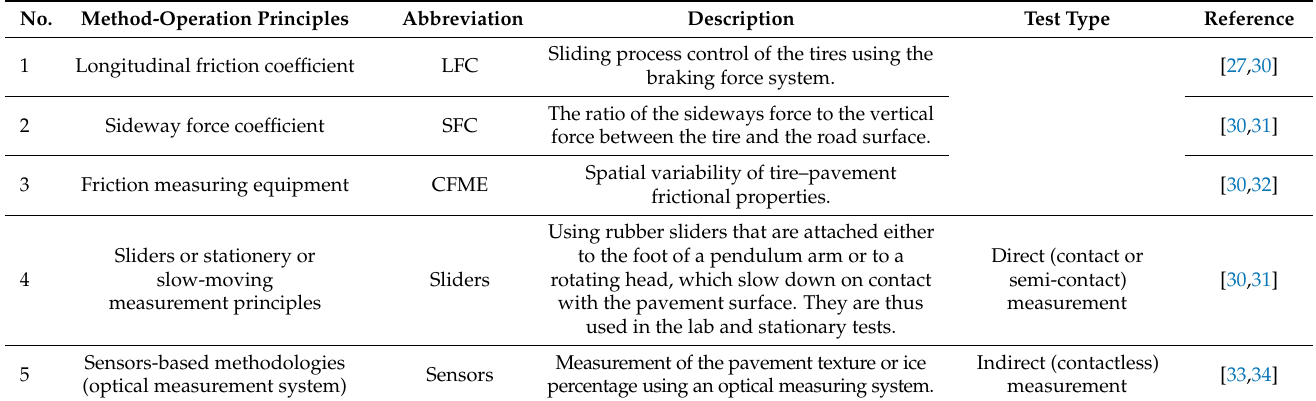
Table 4. Measurement operation principles for skid resistance